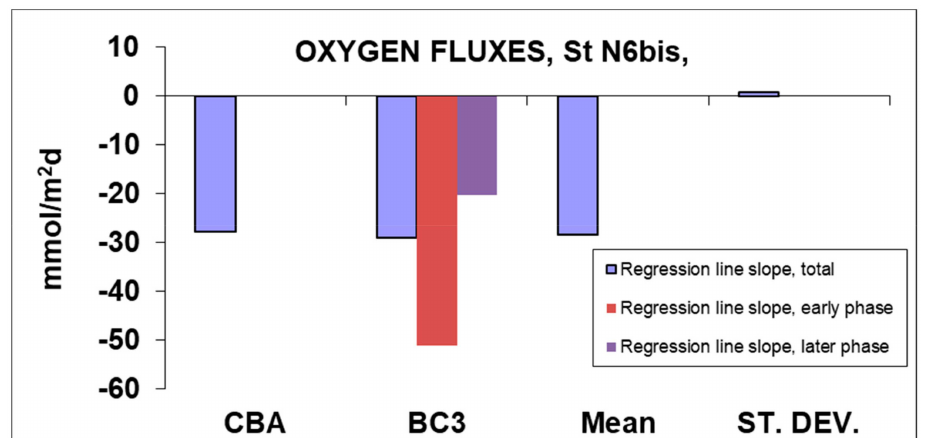
Figure 19. Oxygen fluxes calculated based on the data collected in the CBA and in the BC3 chamber of the Amerigo Lander. Deployment in front of the Po River